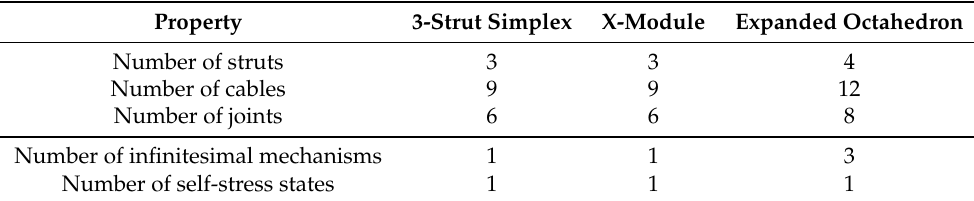
Table 1. Properties of regular tensegrity